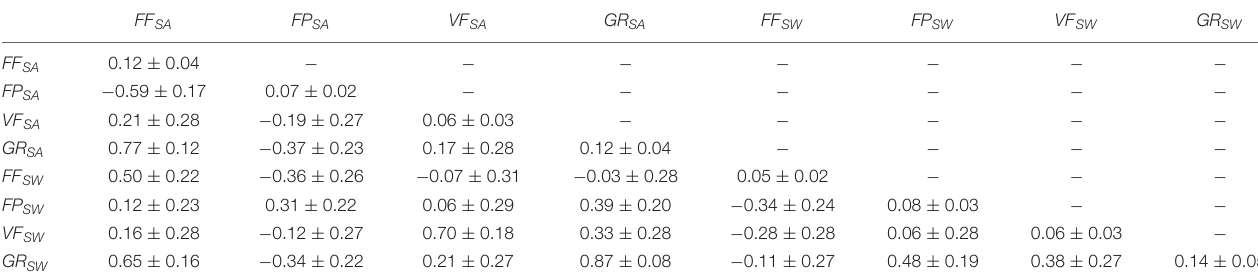
TABLE 4 | The effect common to fullsib as a proportion of the phenotypic variance (on the diagonal) and the correlation between the trait for this effect. FF SA FP SA VF SA GR SA FF SW FP